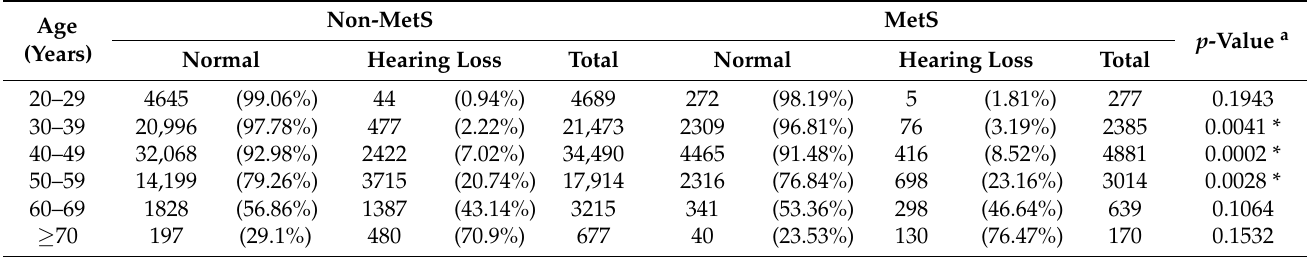
Table 3. Comparison of hearing by age groups in MetS and non-MetS subjects.